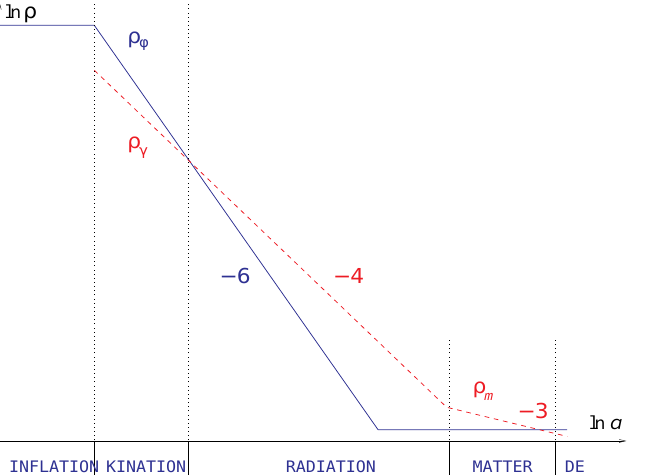
Figure 3. Qualitative behaviour of ρ φ for the potential used in Ref. [63] ( V ∼ exp [ 1 − tanh ( φ )] − 1), which is shallow initially and at late stages and steep in between. In this case, overshoot is deep enough that the field freezes at the shallow part of the potential. After recovering from Hubble damping, it rolls slowly and adheres to late time acceleration (figure is adapted from Ref.